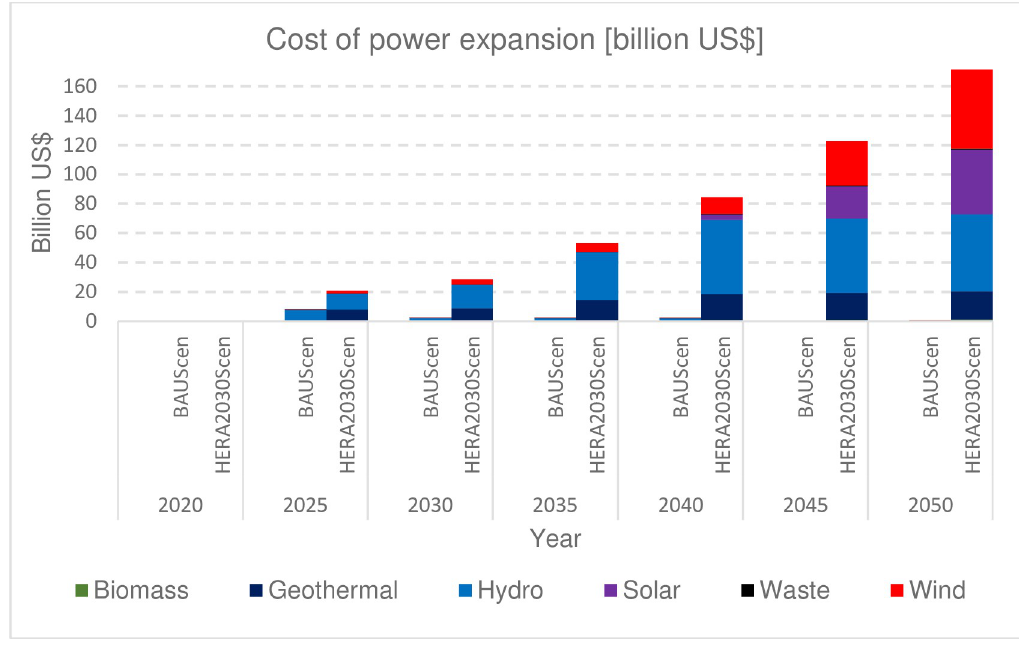
Fig 4. Investment cost of power capacity